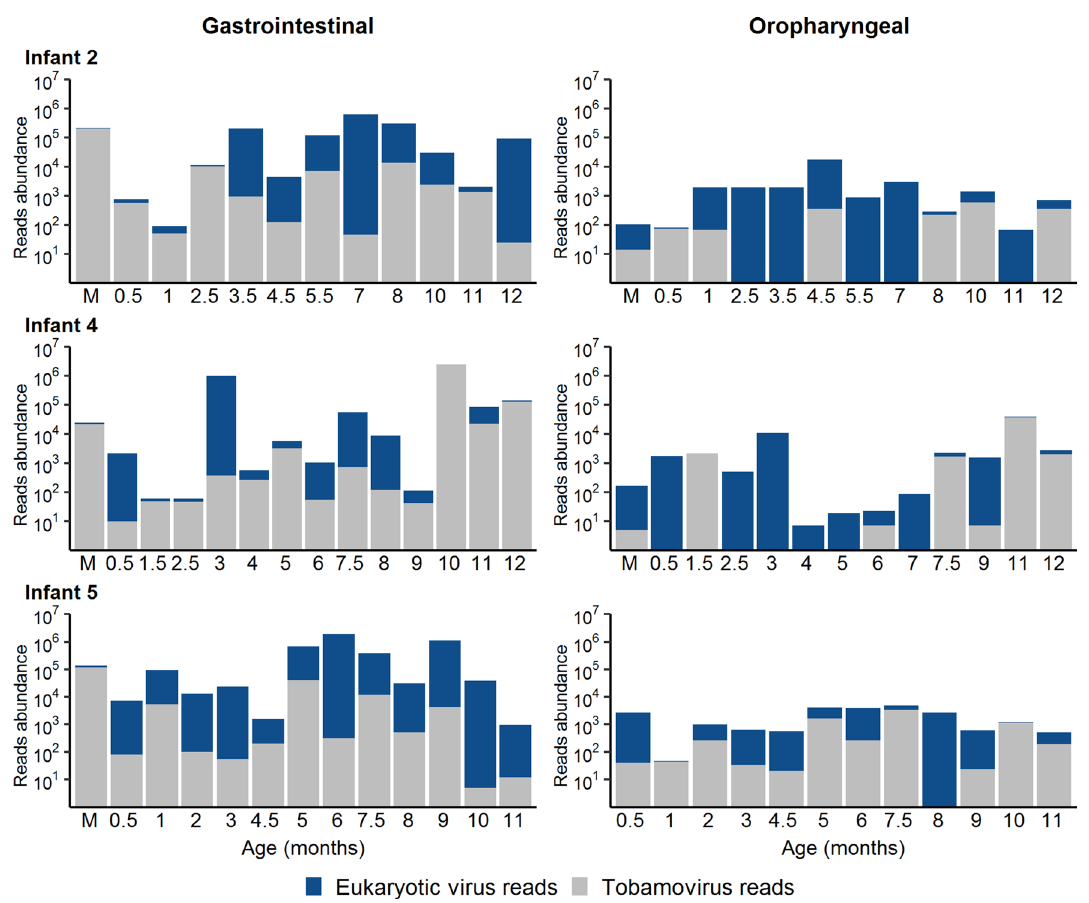
Figure 3. Abundance of tobamovirus and other eukaryotic virus of sequence reads assigned in the samples collected at the indicated age. Reads were normalized according to the total number of reads after quality filtering. M, sample from the corresponding mother. The oropharynx sample of the mother of infant 5 was not